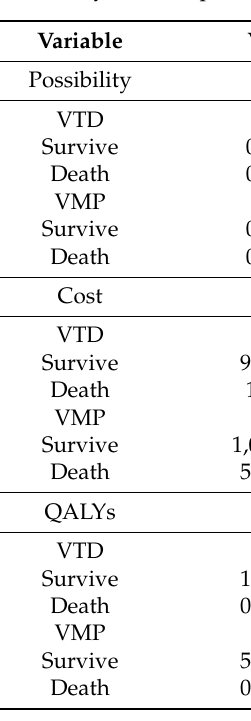
Table 1. Key model